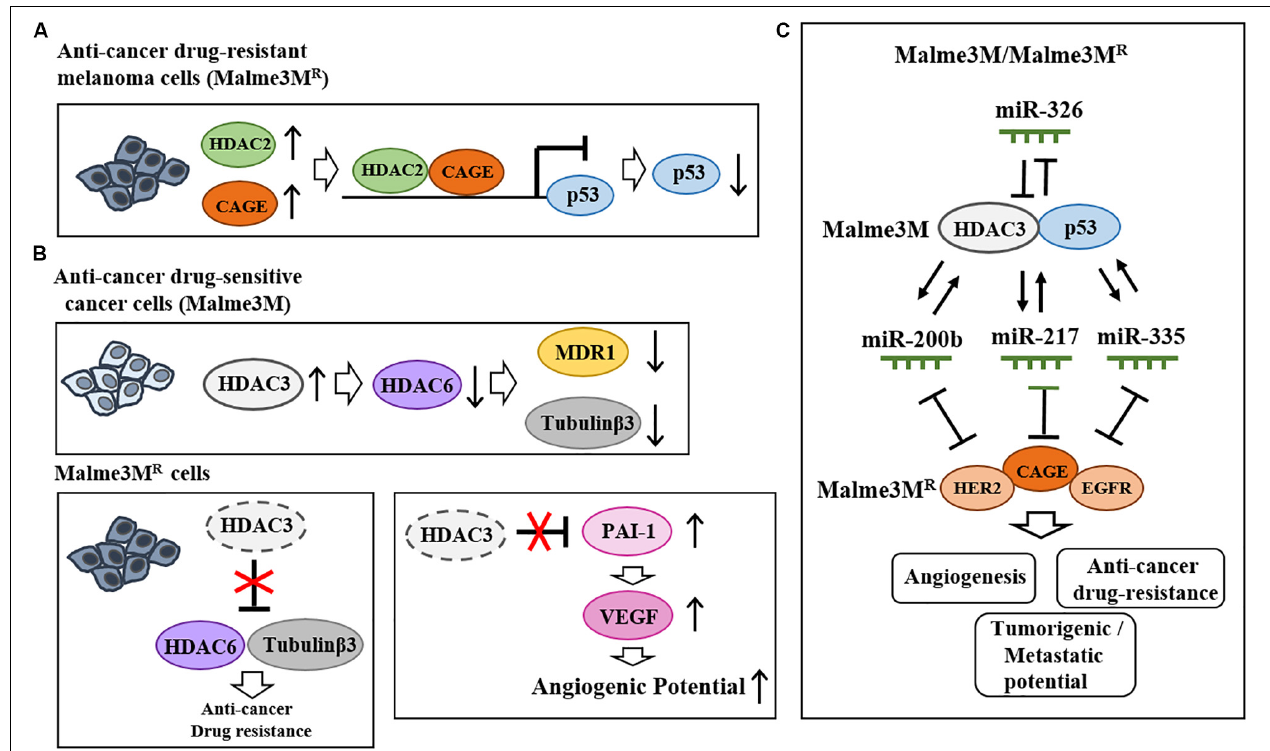
FIGURE 3 | Effects of HDACs on the responses to anti-cancer drugs and melanoma growth. (A) HDAC2 binds to cancer/testis antigen CAGE and directly regulates the expression of p53 to confer resistance to various anti-cancer drugs in melanoma cells (upper). (B) In Malme3M Cells, HDAC3 decreases the expression levels of HDAC6, MDR1, and tubulin β 3 (upper). In Malme3M R cells, HDAC6 interacts with tubulin β 3 and confers resistance to anti-cancer drugs (lower). HDAC3 negatively regulates angiogenic potential by decreasing the expression levels of PAI-1 and VEGF (lower). (C) HDAC3 forms a negative feedback loop with miR-326 and regulates the response to anti-cancer drugs as well as the tumorigenic and metastatic potential of melanoma cells. HDAC3 forms positive feedback loops with miR-200b, miR-217, and miR-335 in Malme3M cells. These miRNAs negatively regulate the expression of CAGE. CAGE interacts with EGFR and HER2 and confers resistance to anti-cancer